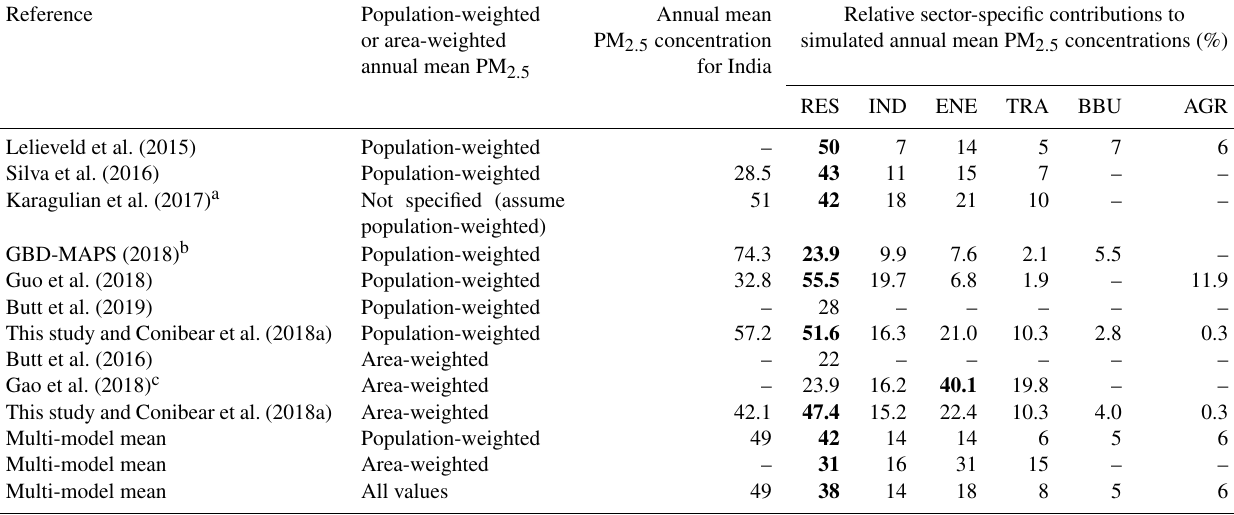
Table 5. Comparison of relative sector-specific contributions to simulated annual mean PM 2 . 5 concentrations over India from this study and previous studies. Emission sectors are residential energy use (RES), industrial non-power (IND), power generation (ENE), land transport (TRA), biomass burning (BBU), and agriculture (AGR). The largest relative contribution for each study is in bold. The average over all studies (multi-model mean) is shown for population-weighted, area-weighted, and all annual mean PM 2 . 5 concentrations and relative